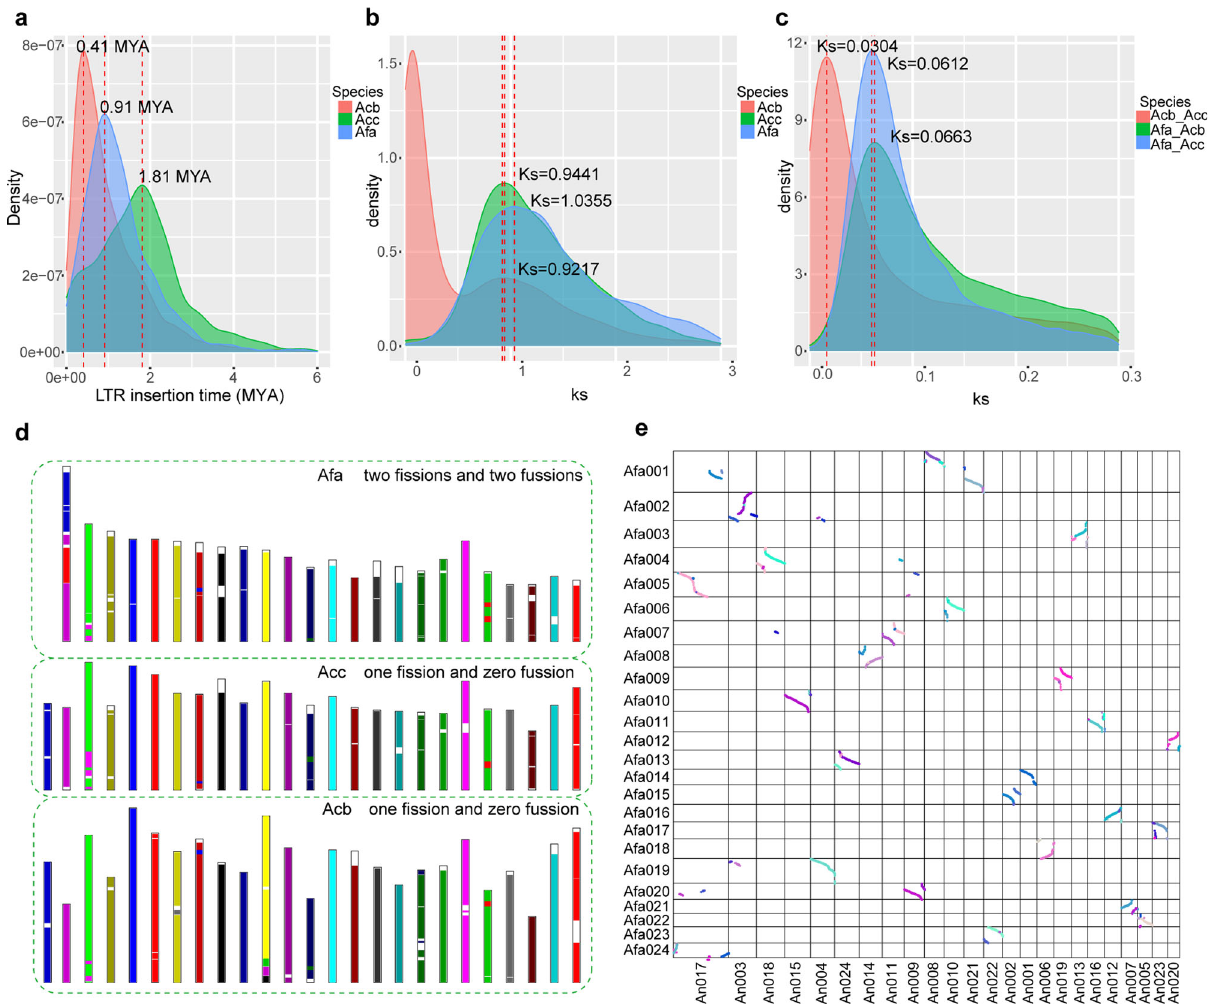
Fig. 2 Genome evolution of A. fasciata , A. comosus var. comosus and A. comosus var. bracteatus . a LTR insertion time estimation. b Ks distribution of Afa, Acc and Acb. c Ks distribution of Afa-Acc, Afa-Acb and Acb-Acc. d Bar plots of Afa, Acc and Acb with respect to the ancient genome. e Dot plot of the